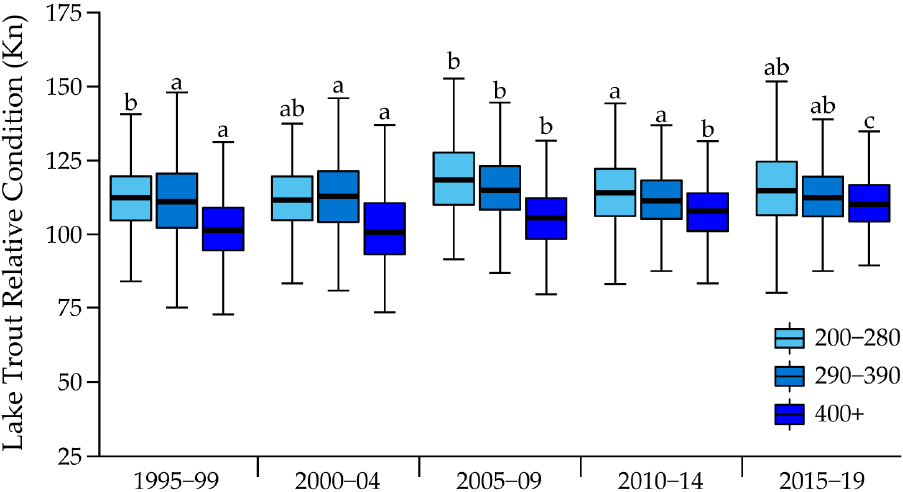
Figure A7. Relative condition (Kn) for three length classes (mm) of lake trout captured in Yellowstone Lake during periods of lake trout population growth (1995–1999, 2000–2004, and 2005–2009) and periods of population decline (2010–2014 and 2015–2019). Same letters (a–c) indicate no statistical difference in mean Kn between the five time periods for each length class. Over the past 25 years, the relative condition of large lake trout (400+ mm) has increased. Relative condition of smaller size classes did not appreciatively change.